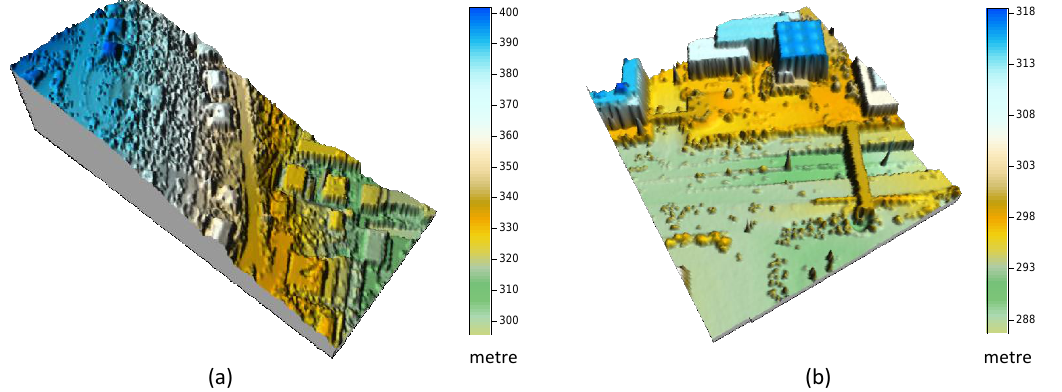
Figure 6. Example of attached objects: ( a ) buildings on steep slopes; and ( b ) bridges connected to ground surface.